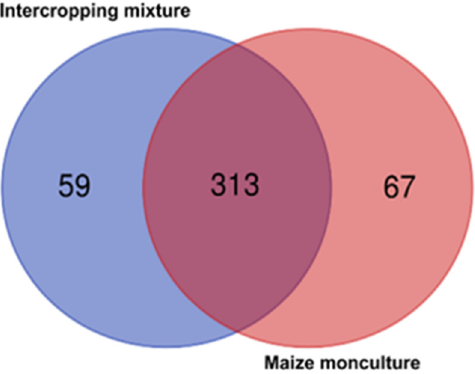
Figure 10. Venn diagram illustrating the numbers of common and different genera in soils under the intercropping mixture and maize monoculture.